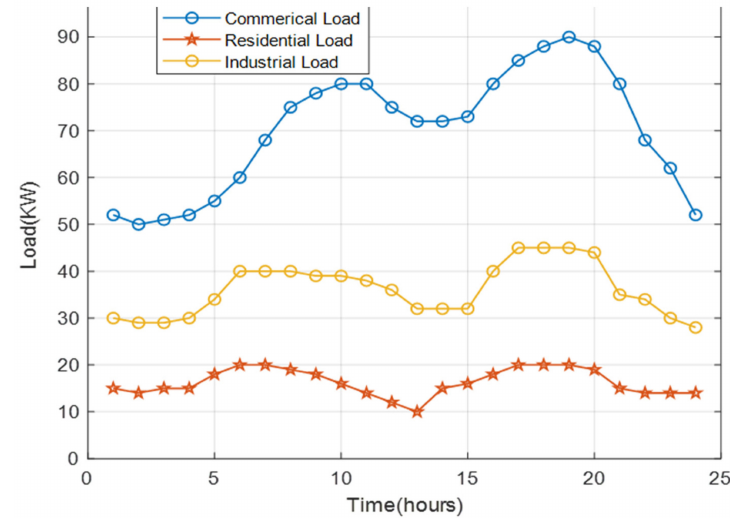
Figure 7. Load curve for three categories of loads.